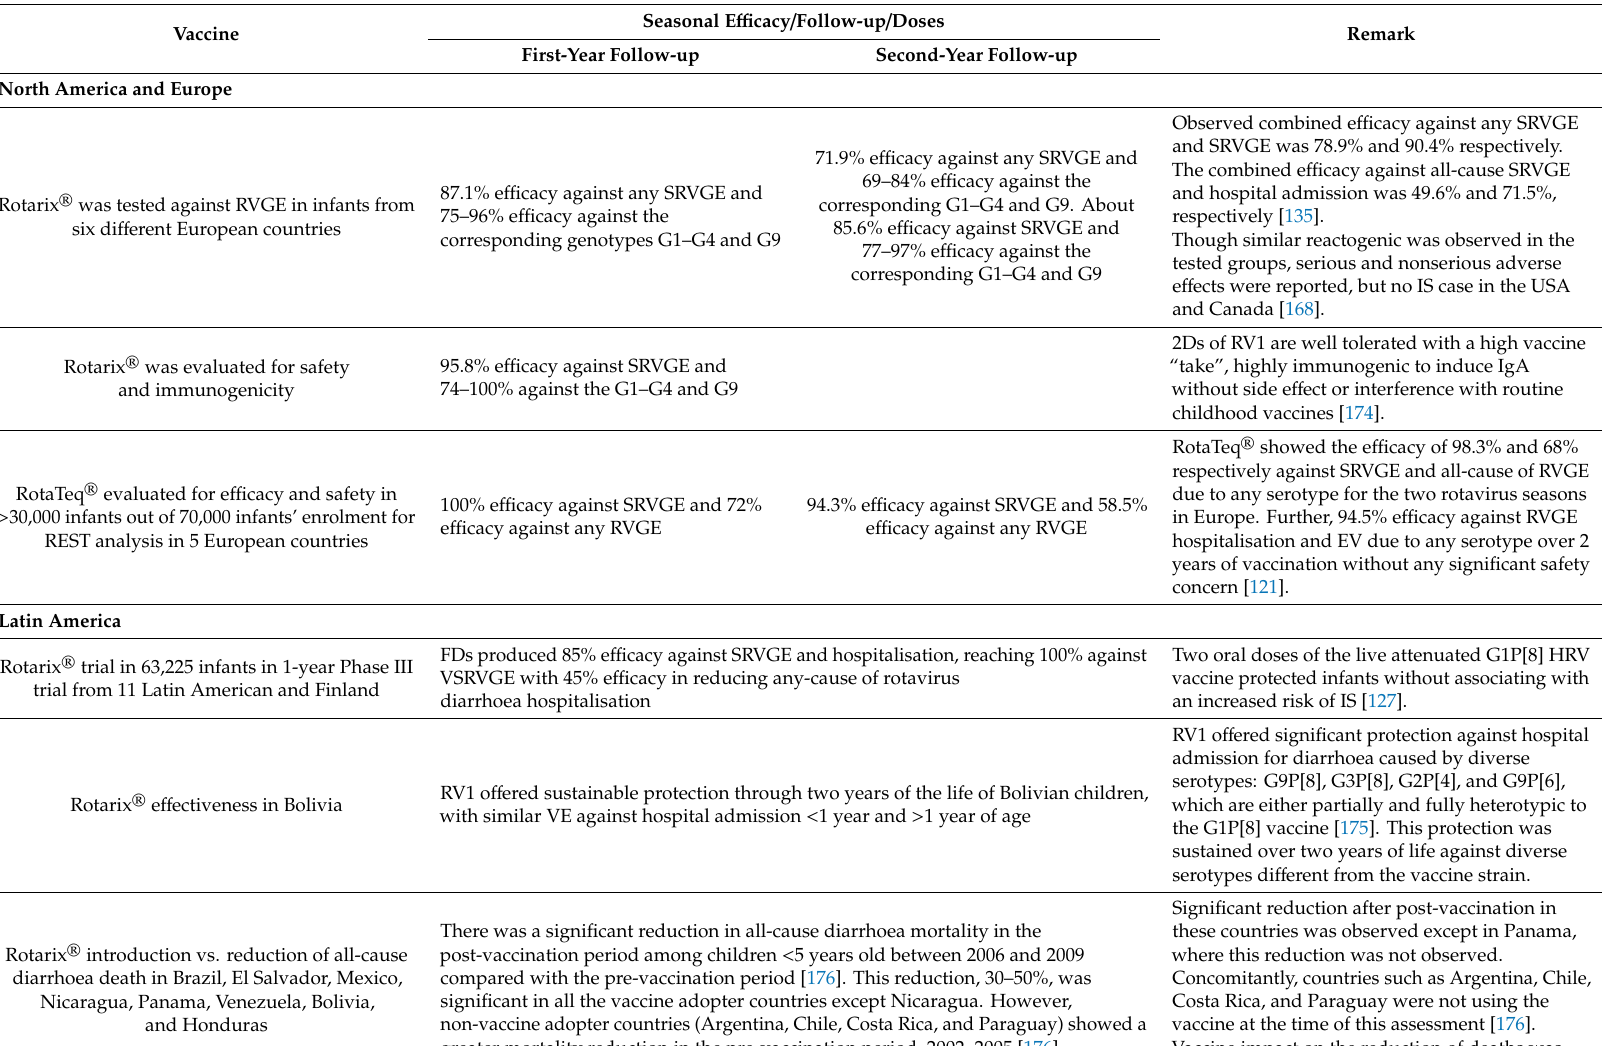
Table 2. Comparative analysis of rotavirus vaccine e ffi cacy and e ff ectiveness in pre-clinical